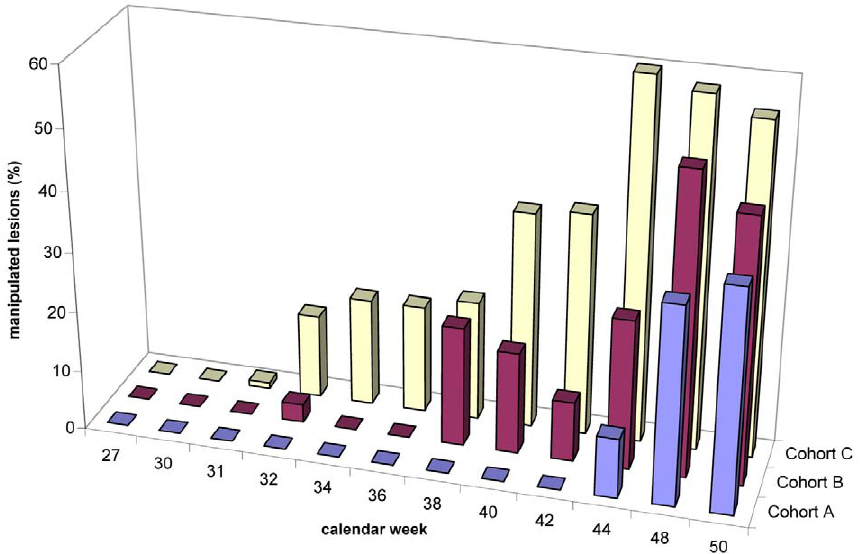
Figure 4. Proportion of manipulated lesions during study period. No observations were carried out between calendar weeks 45–47 (see Materials and